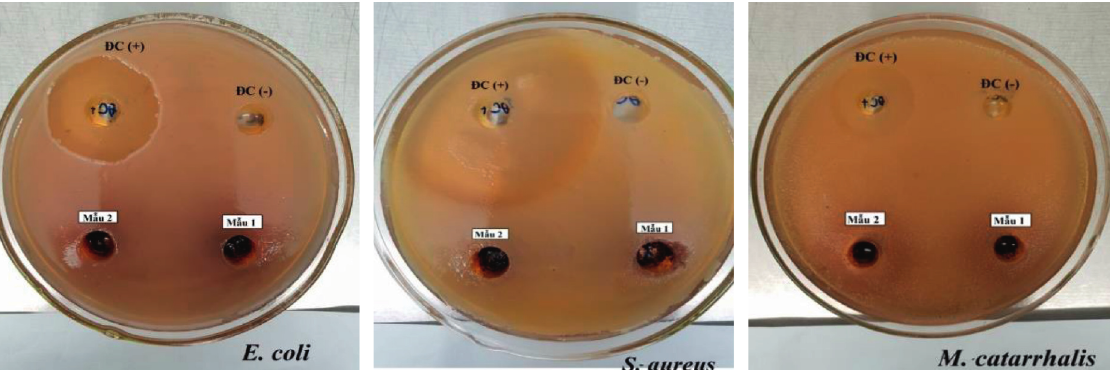
Figure 16: Antimicrobial test results: M01: nasal spray under study; M02: chitosan. First, check the reference results; the reference wells do not have problems to read the test results of the samples.